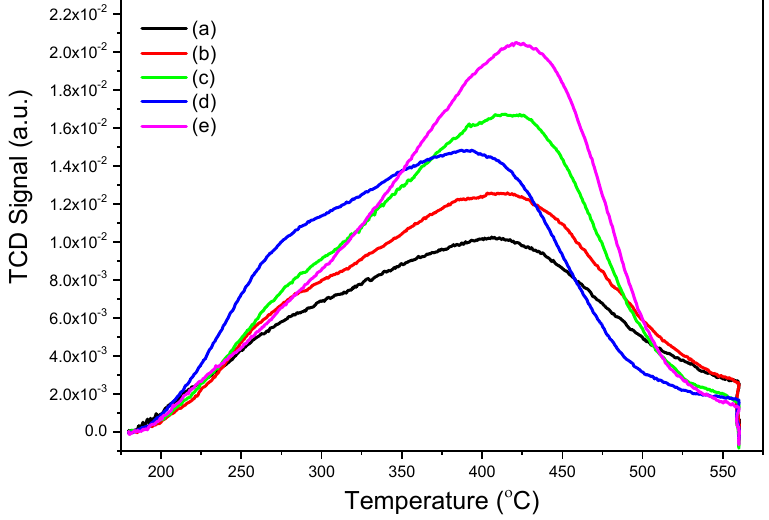
Scheme 1. Reaction pathway for Friedel-Crafts acylation of anisole and propionic anhydride.